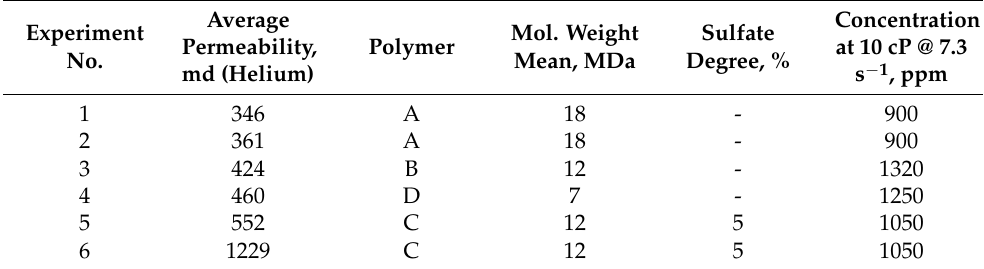
Table 2. Information about core samples and polymers used. The polymers used for this study are exclusively polyacrylamides.